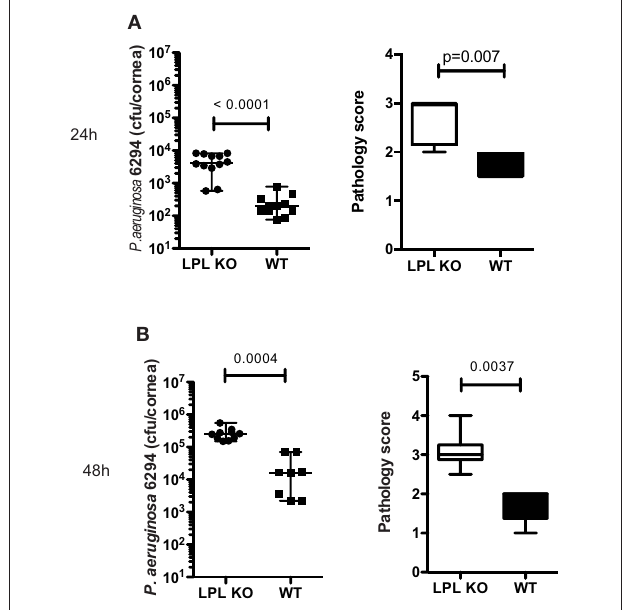
FIGURE 1 | L-plastin deficiency sensitizes to P. aeruginosa -induced keratitis. (A) At 24h post-infectious challenge with P. aeruginosa 6294. Groups of LPL KO mice ( n = 12) and WT ( n = 11) mice were infected with 5 × 10 5 CFU P. aeruginosa 6294 per eye. Data are representative of three independent experiments performed under comparable conditions. p -values are generated using Student’s t -test, p = 0.0001 Pathology scores at 24 post-infection. p -values are generated using Mann-Whitney test, p = 0.007. (B) At 48h post-infectious challenge with P. aeruginosa 6294. Groups of LPL KO mice ( n = 9) and WT ( n = 8) mice were infected with 5 × 10 5 CFU P. aeruginosa 6294 per eye. Data are representative of three independent experiments performed under comparable conditions. P -values are generated using Student’s t -test, p = 0.0004. Pathology scores at 48 post-infection. P -values are generated using Mann-Whitney test, p = 0.0037. Cumulatively these data show significant susceptibility to P. aeruginosa -induced infection in the absence of